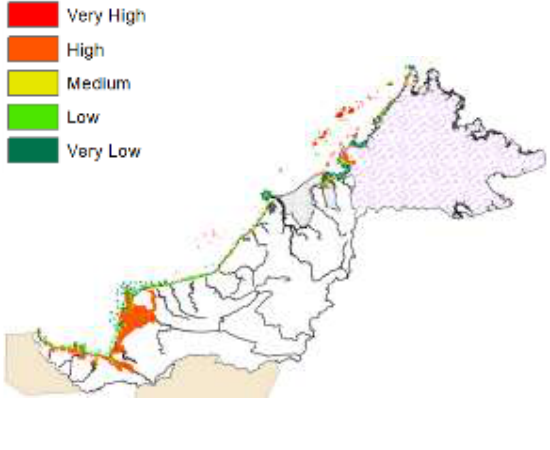
Figure 7: ESR map based on expert 4’s scaling